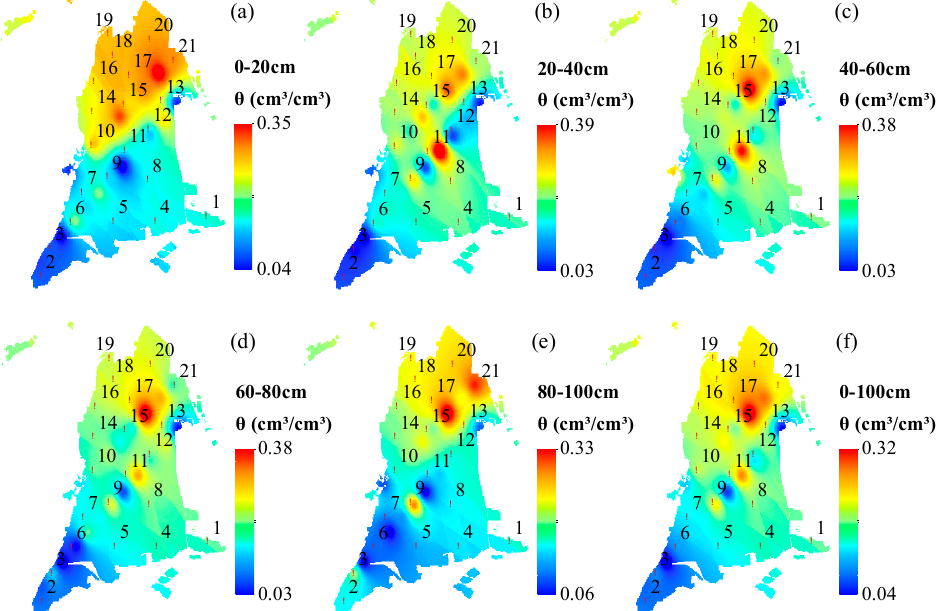
Figure 4. Spatial distribution map of mean soil moistures of layered soils and sediments measured before the first irrigation of Yaoba Oasis: ( a ) to ( f ) represent the mean volumetric moisture ( θ : cm 3 / cm 3 ) within 20–40 cm, 40–60 cm, 60–80 cm, 80–100 cm, and 0–100 cm, respectively.